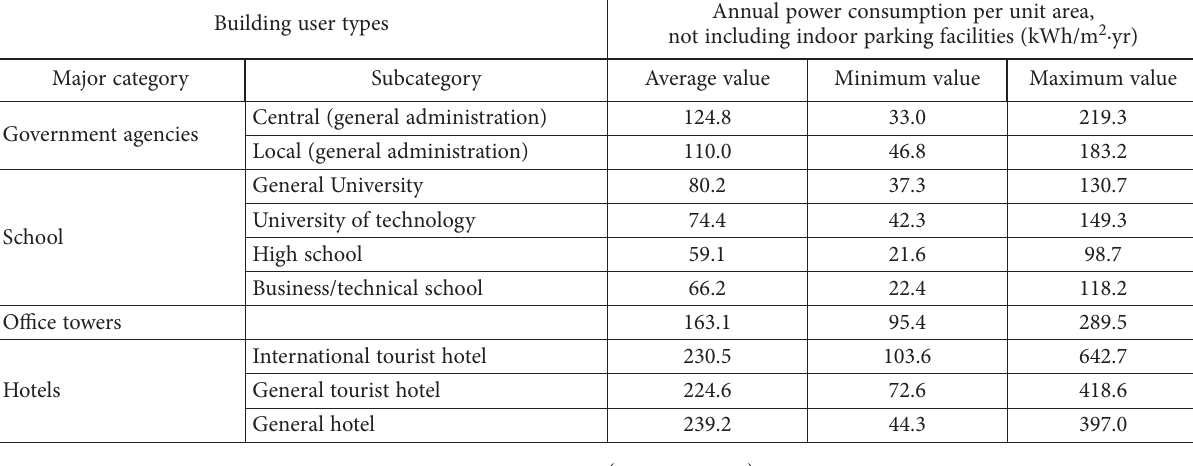
Table 3. Annual Electrical Power Consumption by Building Occupant per Unit Area, 2015 Building user types